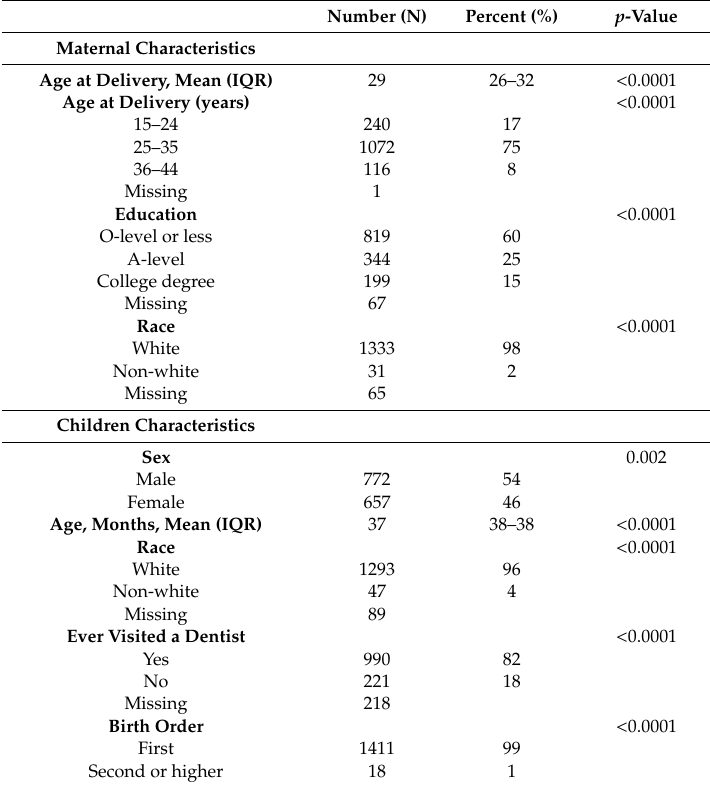
Table 1. Demographic characteristics of mothers and their children at baseline: Avon Longitudinal Study of Parents and Children.